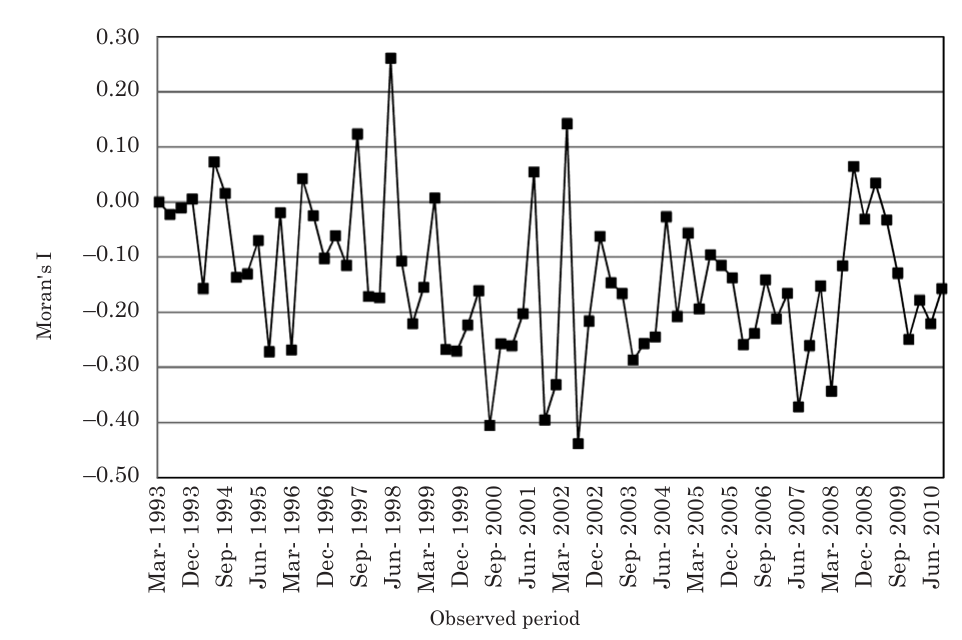
Figure 1. Spatial autocorrelation tests based on the demographical spatial